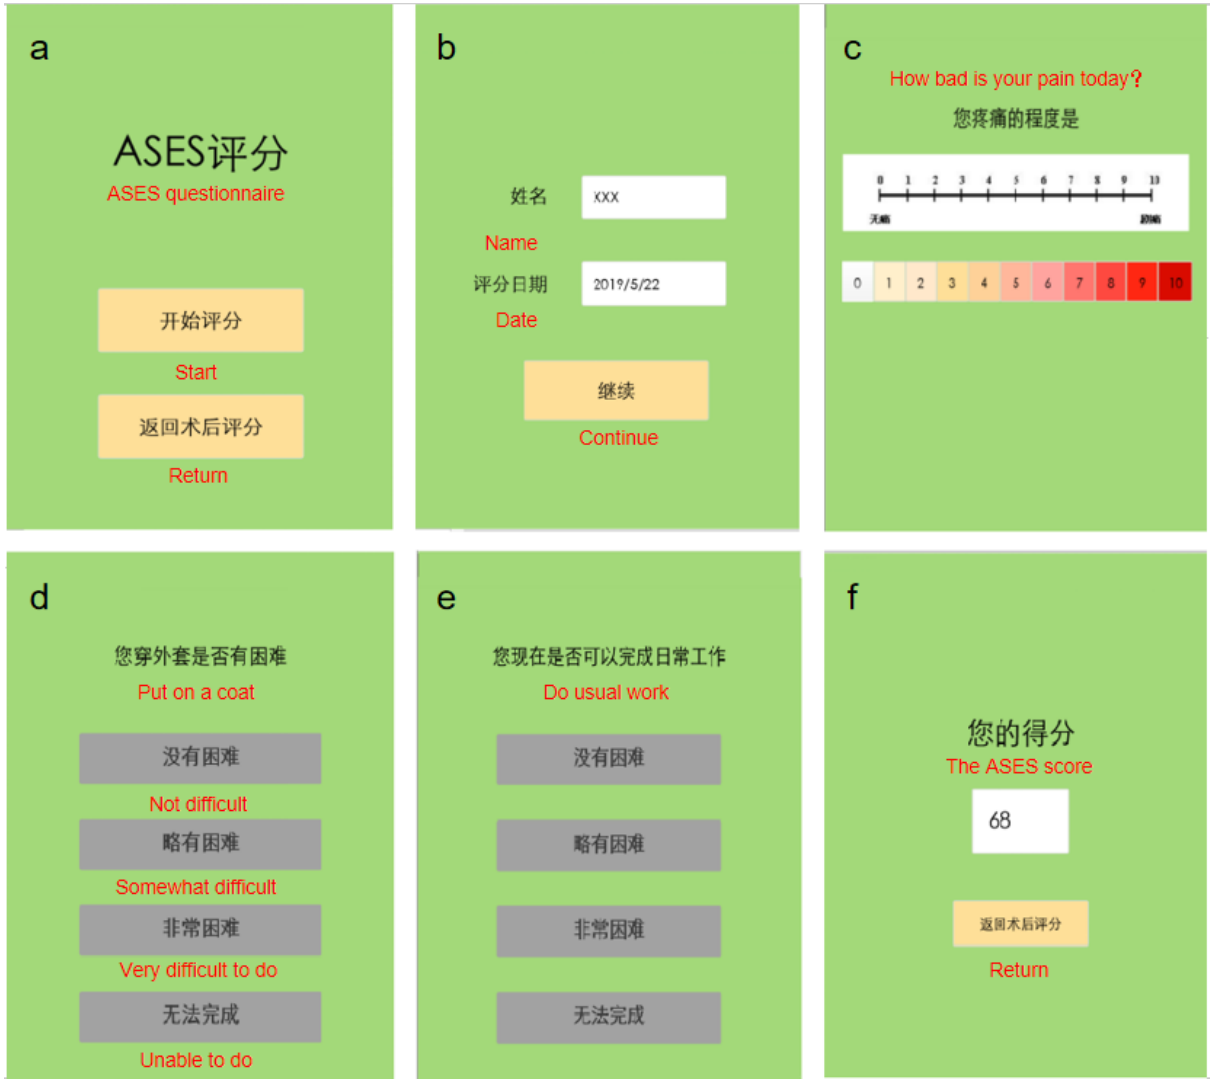
Figure 1. Screenshots of the iPad Mini screen showing (A) the login screen, (B) the home screen, (C) VAS scores, (D) and (E) ADL scores, and (F) the result screen. ADL: activities of daily living; ASES: American Shoulder and Elbow Surgeons Standardized Shoulder Assessment Form; VAS: Visual Analogue